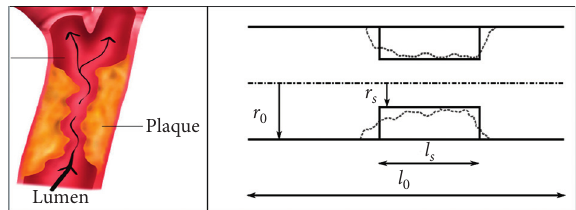
Figure 1: Sketch of arterial vessel segment with stenosis and 0D- model